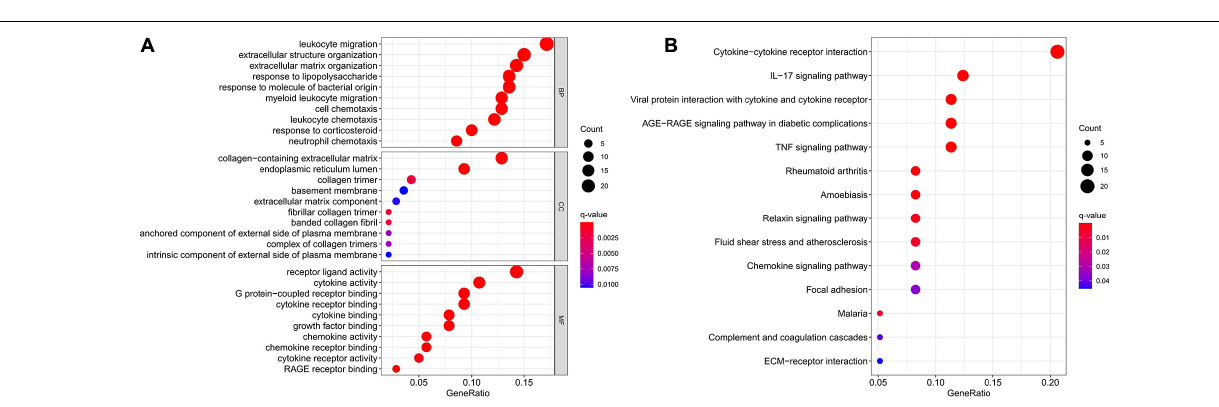
FIGURE 3 | GO and KEGG enrichment analysis of DEMs. (A) GO enrichment analysis of DEMs. (B) KEGG enrichment analysis of DEMs. GO, Gene Ontology; KEGG, KyotoEncyclopedia of Genes and Genomes; DEMs, differentially expressed messenger